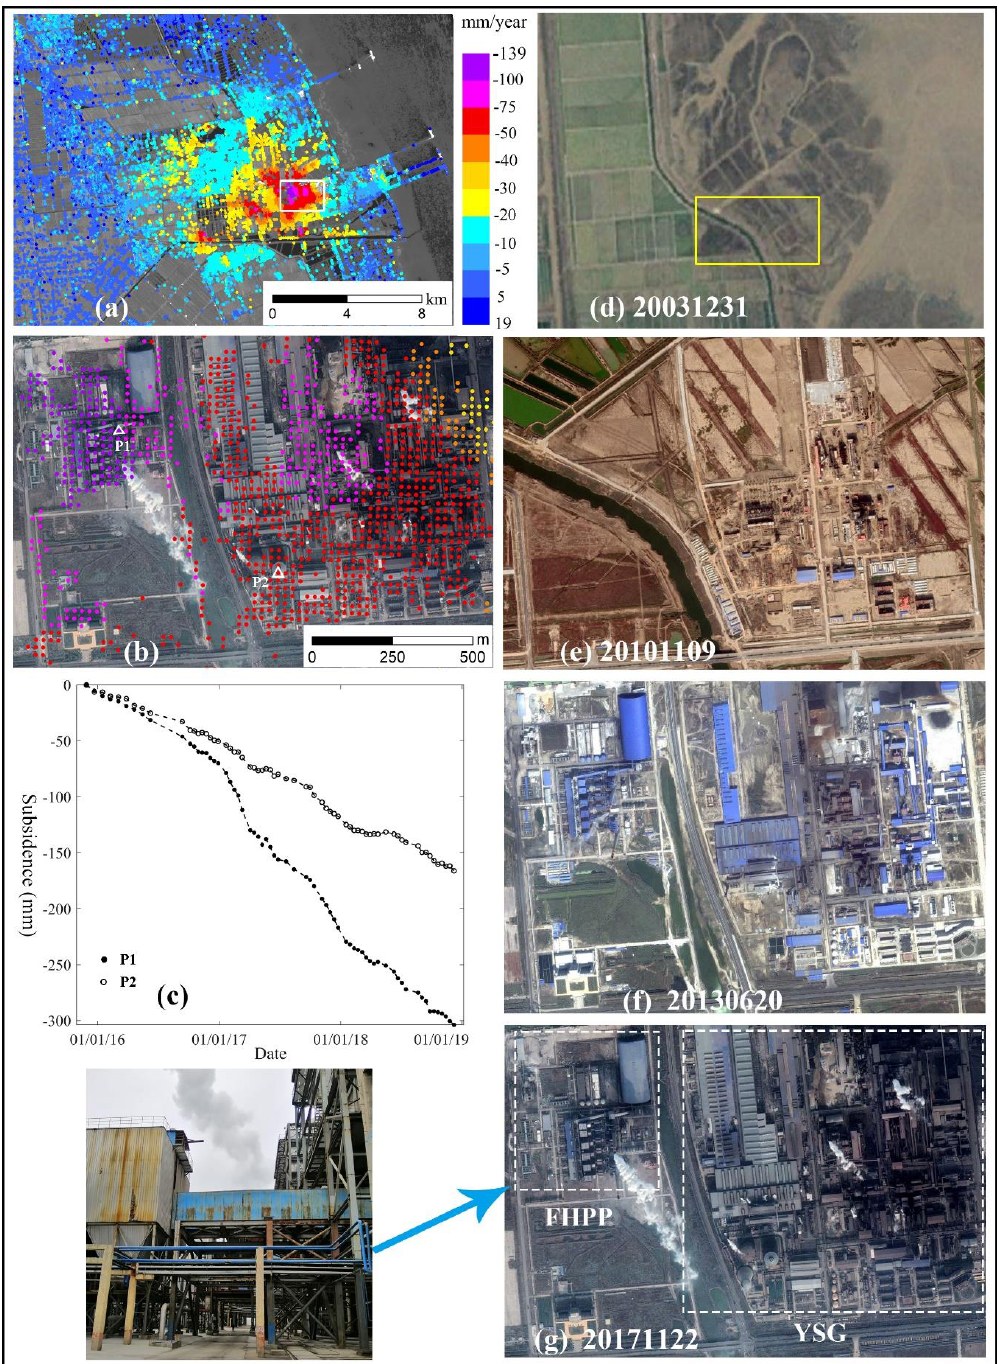
Figure 11. The enlarged view of Zone C in Figure 4 is shown in ( a ). The MSV within the white-line AOI in ( a ) is shown in ( b ). ( d – g ) are 4 historic images of the AOI which shows the land-use transition from farmland and muddy beach in 2003 to industrial districts in 2017. The yellow-rectangle region in ( d ) corresponds to the image area of ( e – g ). The subsidence time series of two CPs marked by white-triangles in ( b ) is shown in ( c ). An on-site photo of FHPP is shown to the left of ( g